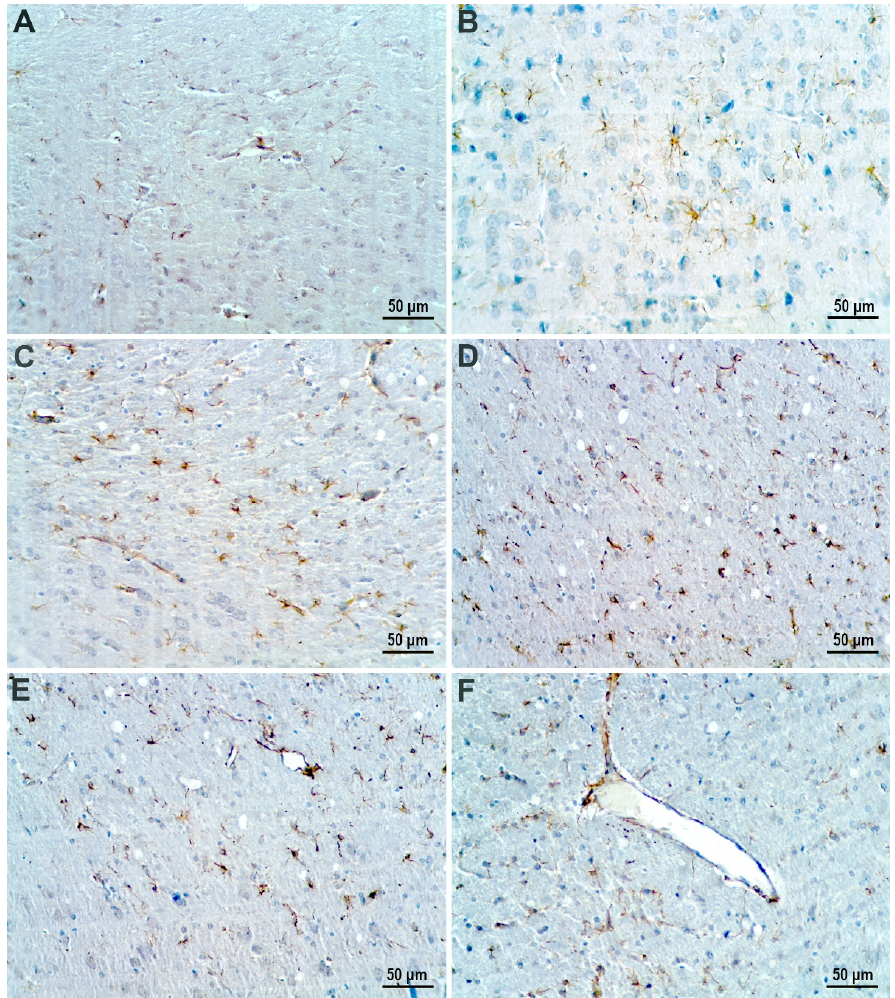
Figure 13. GFAP immune-stained sections of cerebral-cortex tissue. ( A , B ) Control group. ( C ) Groups treated with low dose of AgNP and sacrificed immediately after treatment. ( E ) Groups treated with high dose of AgNP and sacrificed immediately after treatment. ( D ) Groups treated with low dose of AgNP and sacrificed 15 days post-treatment. ( F ) Groups treated with high dose of AgNP and sacrificed 15 days post-treatment.